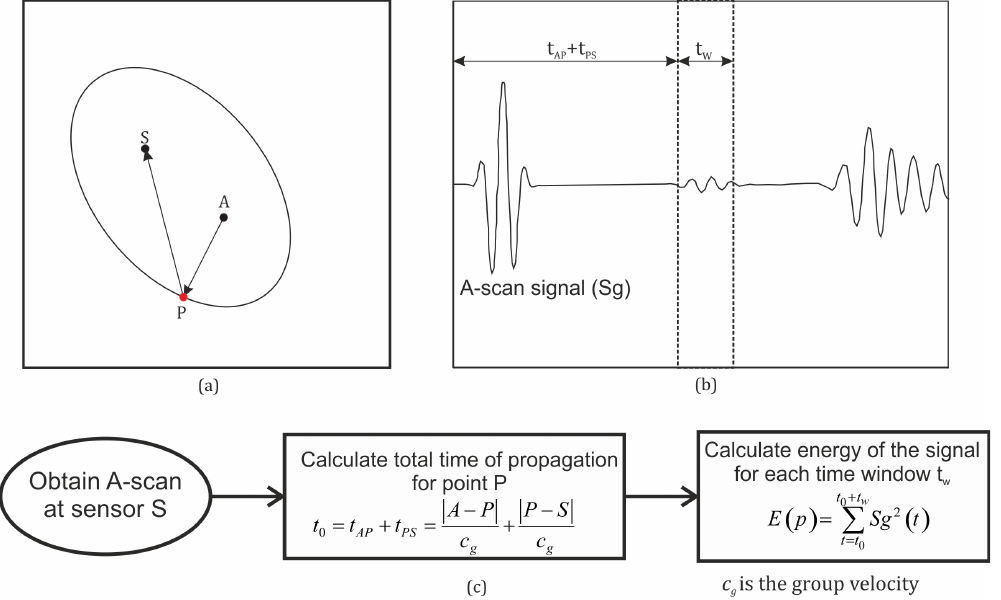
Figure 10. Scheme for obtaining ellipses from the A-scans. ( a ) Plate with the actuator (A), sensor (S),